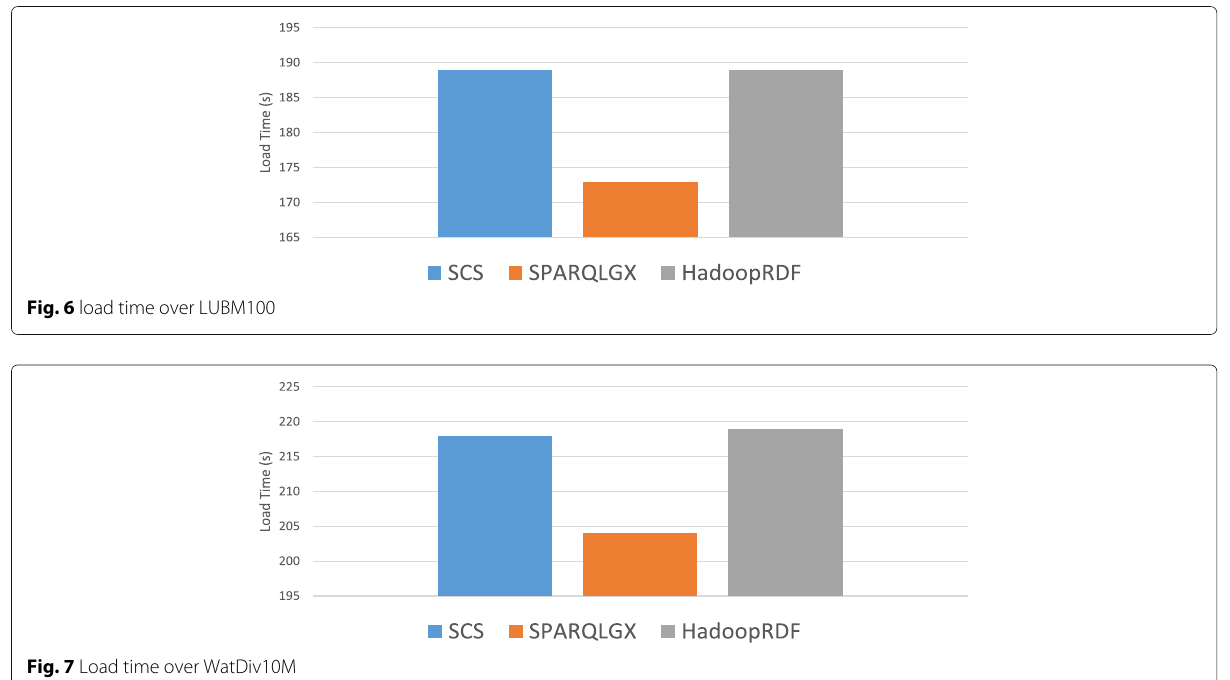
Fig. 7 Load time over WatDiv10M